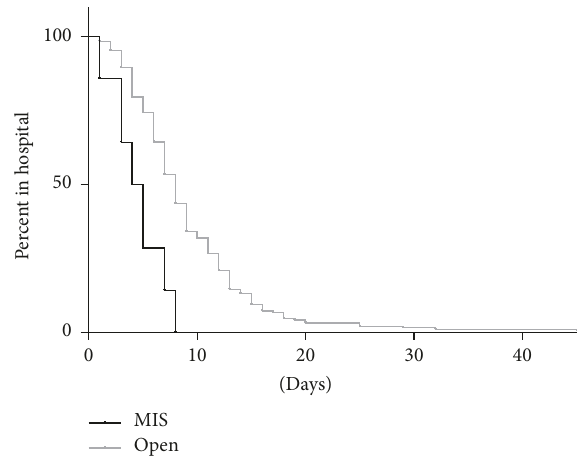
Figure 3: Comparison in LOS between MIS and open approach